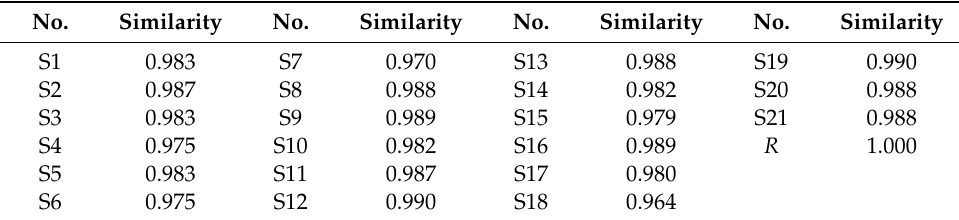
Table 4. Similarity of the G. elata tuber